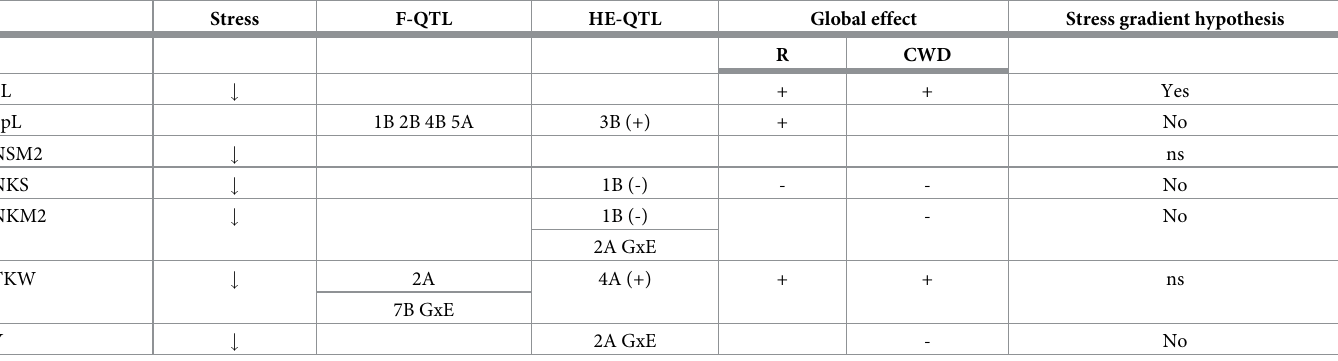
2A GxE - No R: Rainy conditions, CWD: controlled water deficit conditions, SL: stem length, SpL: spike lenght, NSM2: number of spikes per m 2 , NKS: number of kernels per